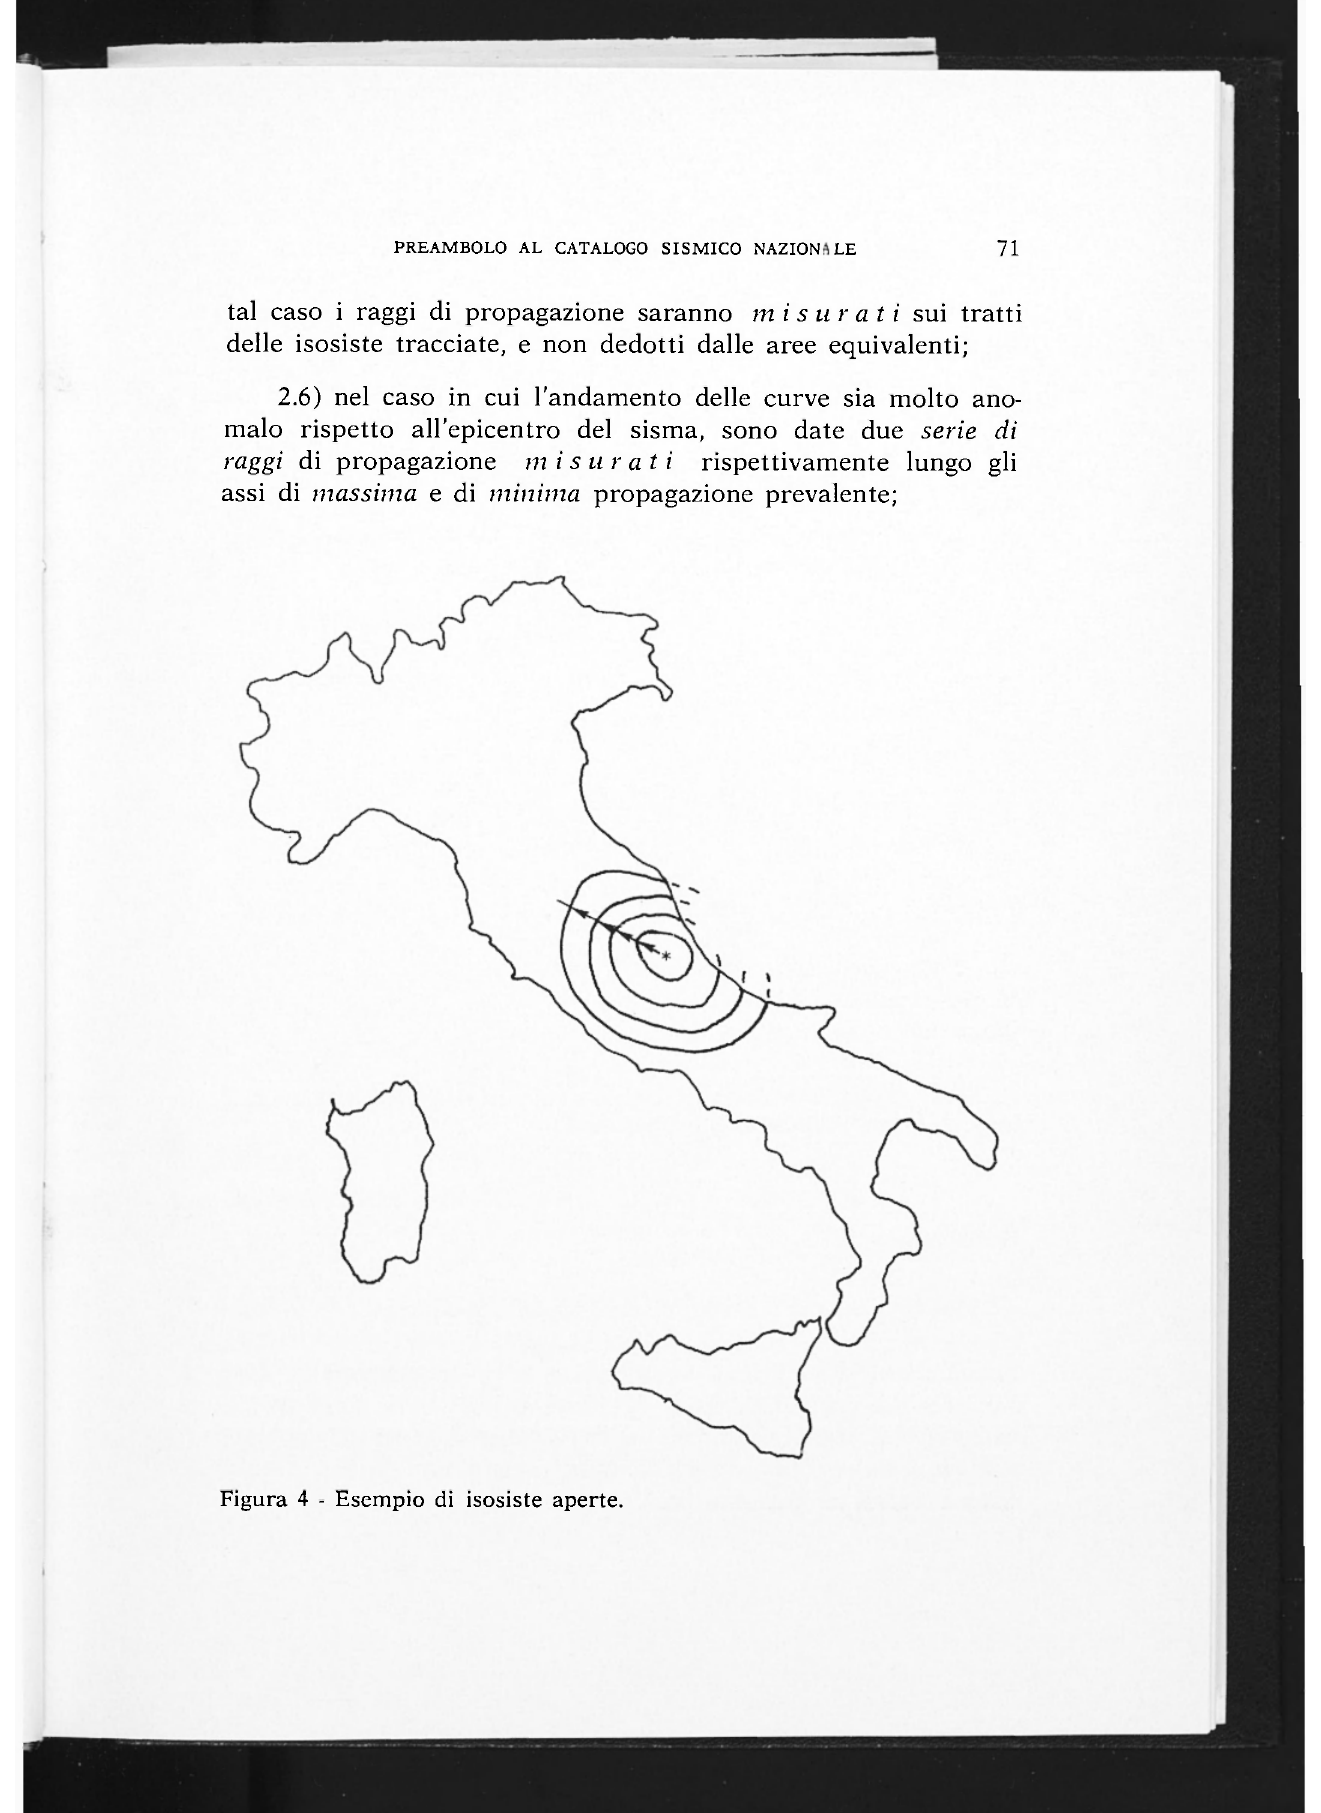
Figura 4 - Esempio di isosiste